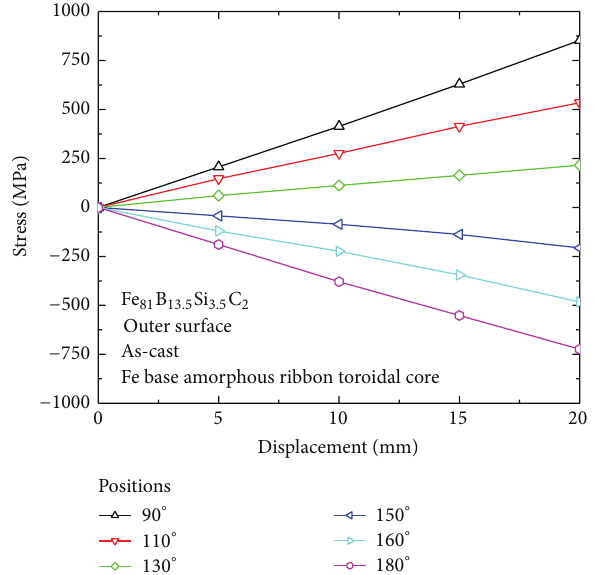
Figure 10: Stress distribution on the outer surface of the as-cast, Fe based, 0.5 mm thick, and 30 mm inner diameter amorphous toroidal transducer core for 90 ∘ , 110 ∘ , 130 ∘ , 150 ∘ , 160 ∘ , and 180 ∘ positions.